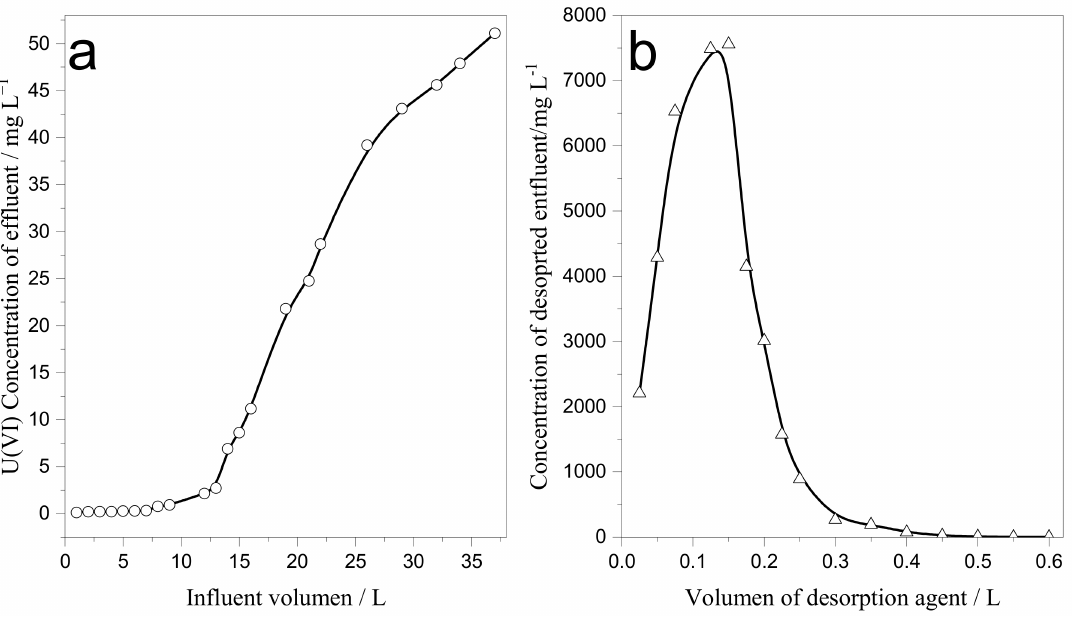
Figure 12. Uranium initial concentration penetration test at 50 mg L − 1 (( a ): breaking through curve; ( b ): desorption curve).